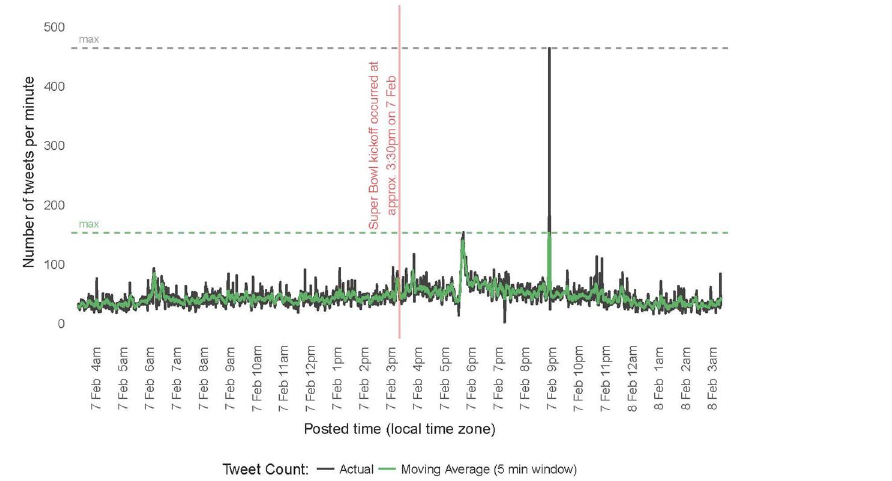
Fig 4. Tweets per minute during the start of the Super Bowl 50